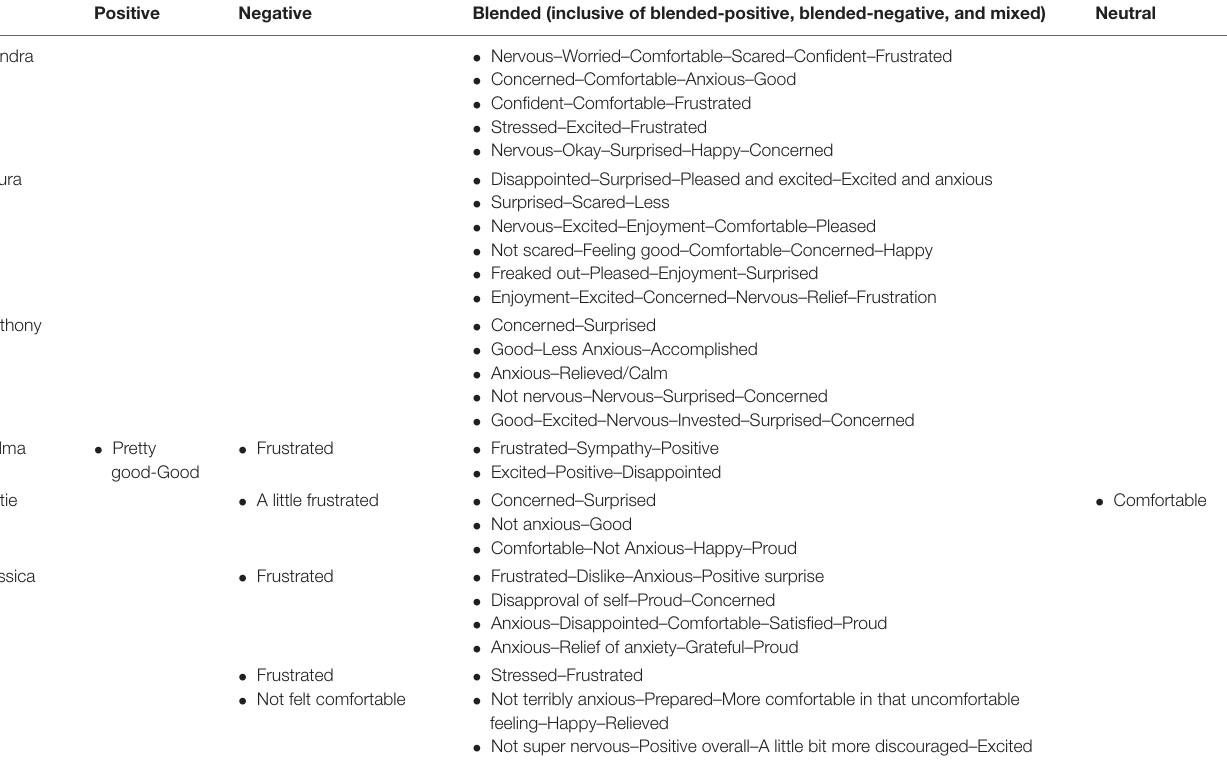
TABLE A2 | Categorization of teachers’ emotions by type from the post-coaching conversations.